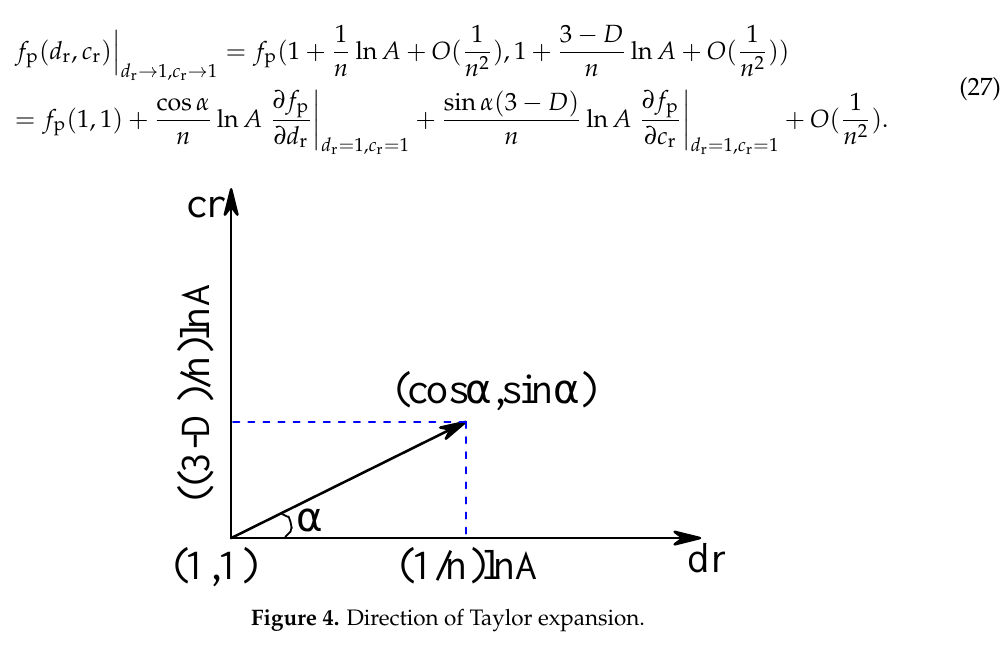
Figure 4. Direction of Taylor